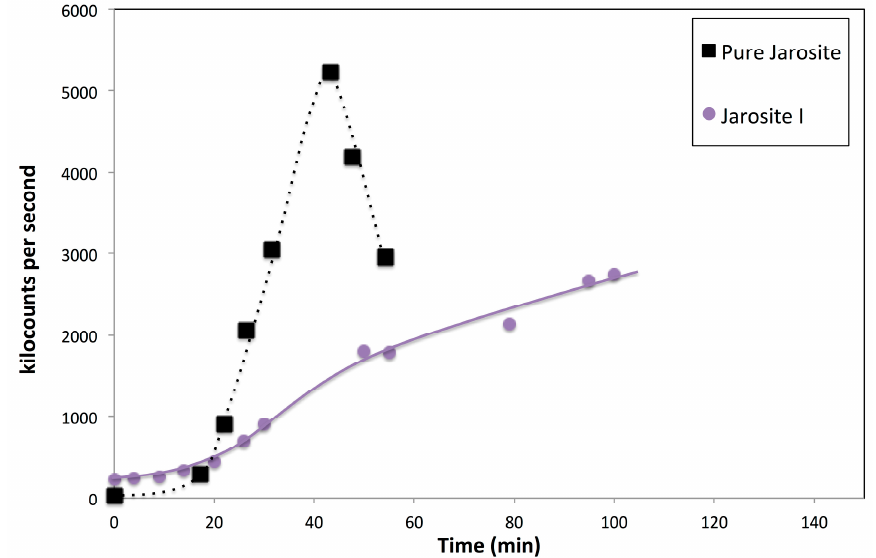
Figure 14. DLS results of particles counted (kilocounts per second) versus time for pure jarosite and jarosite I.